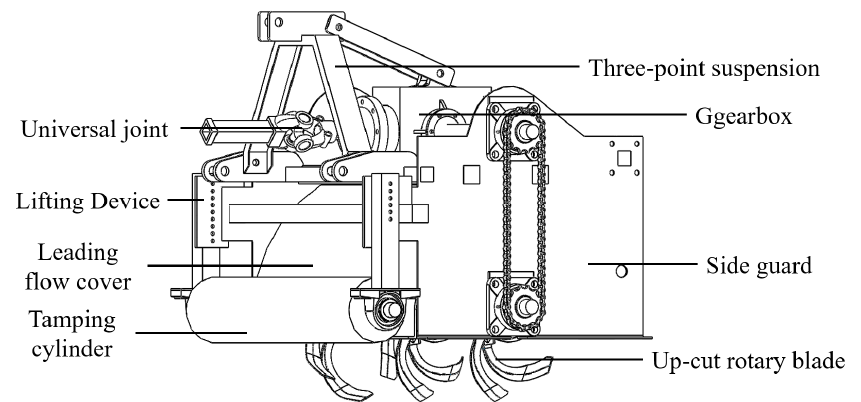
Figure 1. General structure of reverse rotary tiller.